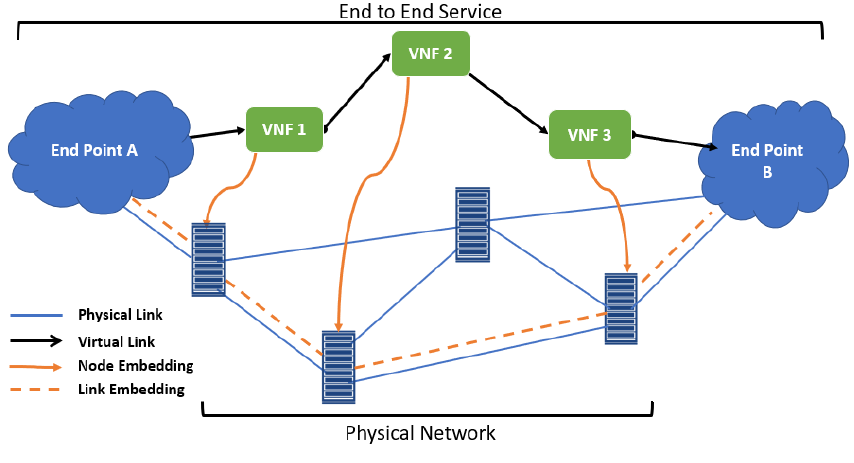
Figure 2. VNF-FG